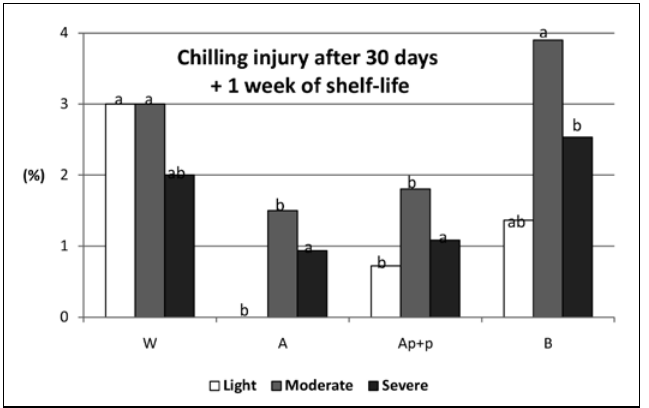
Fig. 2 - Effect of treatments on the severity of chilling injury on clem- entine, after 30 days of storage at 6±1°C followed by one week at 20±2°C. Each treatment was applied to three replicates of 200 fruits each. Water treatment was used as control. Columns marked with the same letters are not statistically different ac- cording to Tukey’s test (P = 0.05). W= Water control, prehar- vest treatments; A= Potassium phosphite, preharvest treatments (2.5 g/L); Ap+p= Potassium phosphite, pre- (2.5 g/L) and postharvest treatments (4 g a.i./L); B= Phosetyl-Al, preharvest treatments (2.5 g/L).